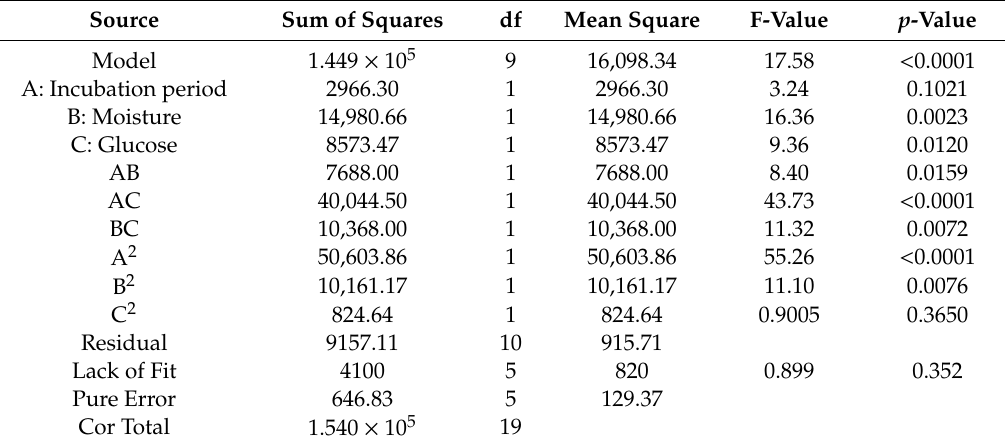
Table 4. Analysis of variance for the designed central composite design for biosurfactant